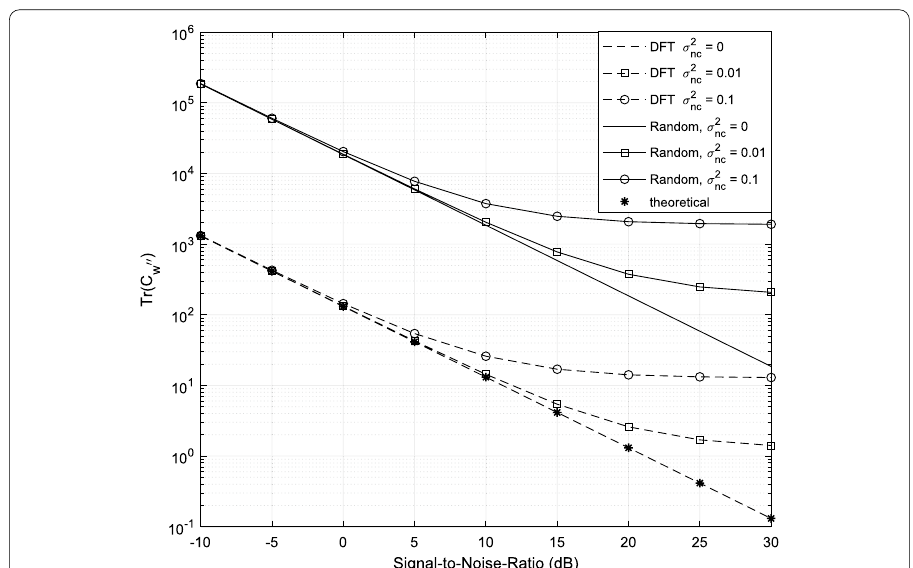
Fig. 4 Total noise power evaluation for a combiner Matrix based on (i) DFT matrix and (ii) random phase shifters for σ 2 nc = { 0,0.01,0.1